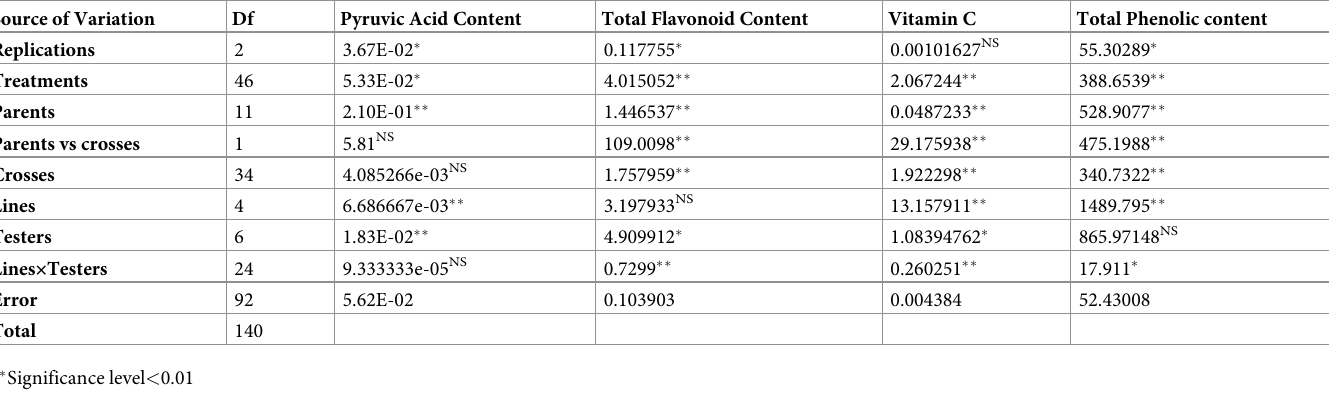
Table 7. Analysis of variance for parent’s vs crosses indicating significance level of heterosis for nutraceutical traits. Source of Variation